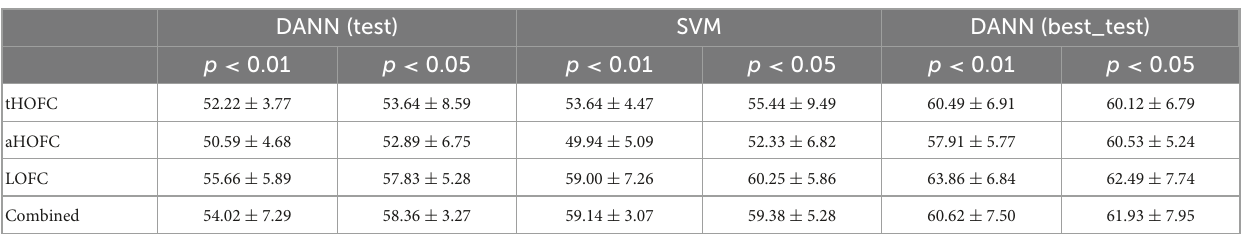
TABLE 3 Average Classification